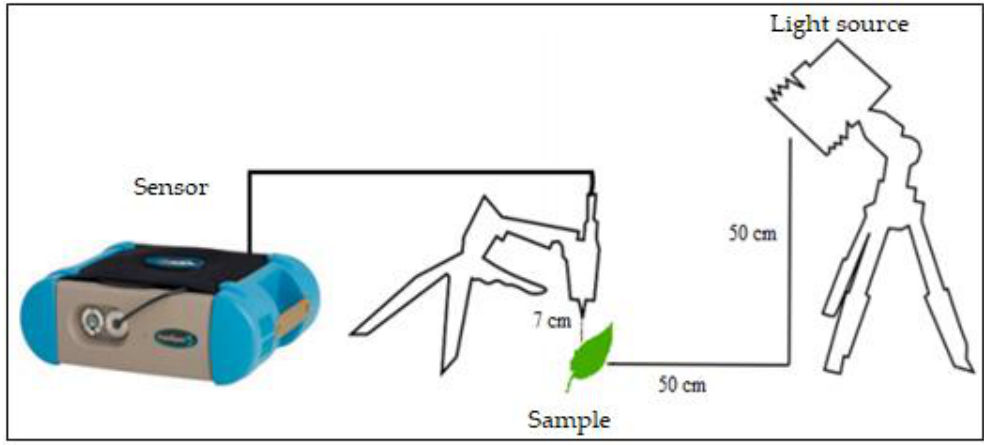
Figure 3. Geometry of radiometric data acquisition. Source: [40], adapted by the author. After eliminating any non-representative measurements, the mean radiance was calculated. The values for spectral radiance were converted into bidirectional reflectance factors as per Equation (1):